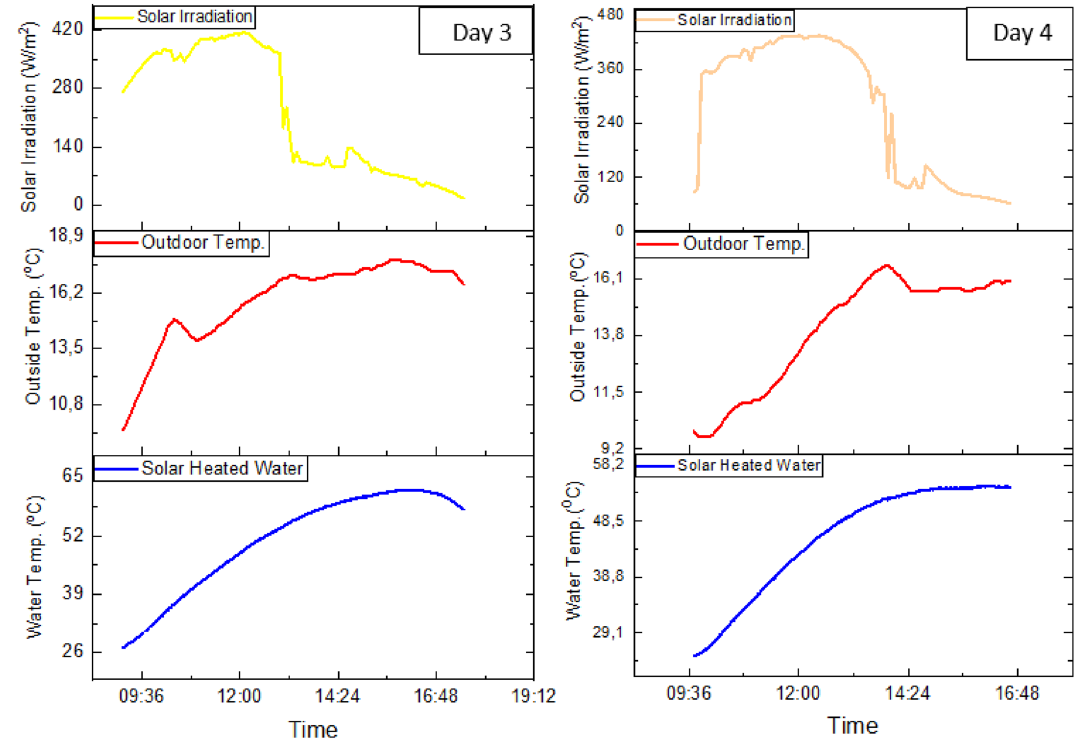
Fig. 5 Solar irradiation, outdoor temperature and solar heated water temperature for day 3 and day